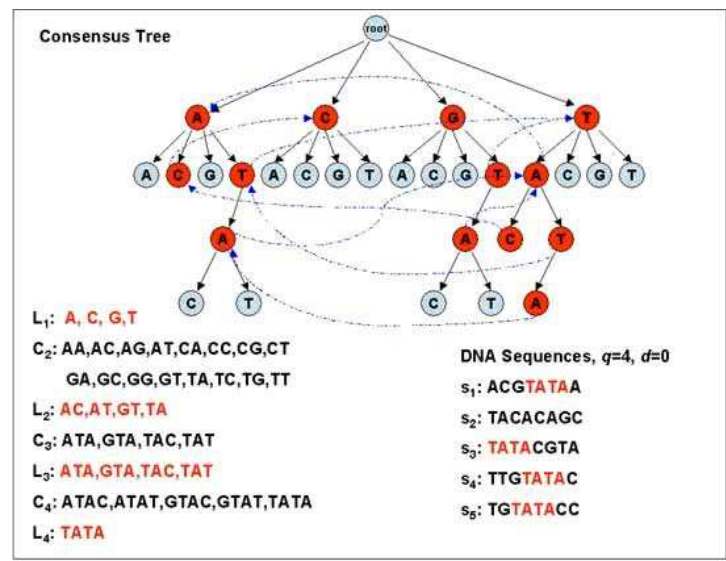
Figure 1: Consensus tree of the sample S= { s1, s2, ··· , s5